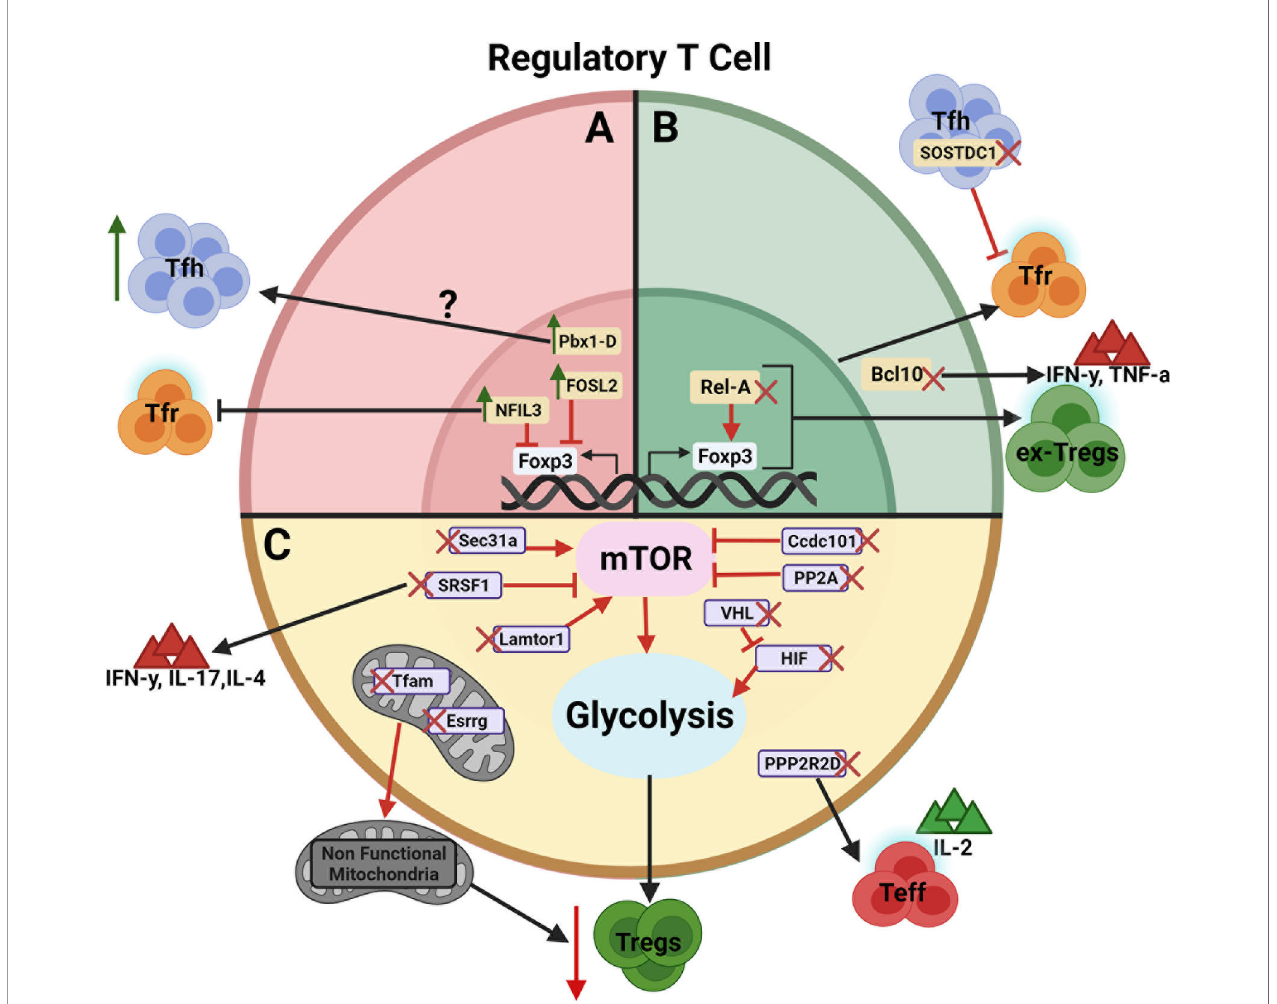
FIGURE 1 | Schematic view of genes regulating Treg cell development, function, and/or stability. The genes are presented according to their effect on Treg cells. (A) Negative regulators whose over expression leads to an expansion of Tfh cells or inhibition of Tfr cells (Green arrows indicates gene overexpression).? indicates that the Pbx1-d direct target is unknown. (B) Positive regulators whose deletion leads to the inhibition of Tfr cells or the generation of ex-Treg cells producing IFN g and TNF a (Red X indicates gene deletion). (C) Genes regulating Treg cells through their metabolism by way of mTOR, glycolysis and/or mitochondria metabolism leading to decreased immunosuppressive activity. Red arrows between genes and their target indicate an enhancing effect with expression of the target being decreased by the gene deletion. Red blocked arrows indicate an inhibitory effect with expression of the target being increased by the gene overexpression. Figure created with